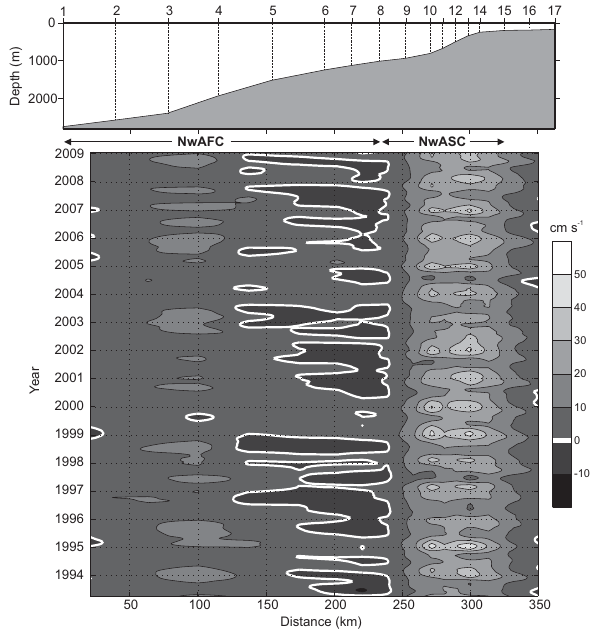
Fig. 2. Upper figure: bottom topography with the fix hydrographic stations in the Svinøy section. Lower figure: Hovm¨oller plot of sur- face currents through the section based on the absolute sea surface dynamic height data. The data are three months moving averages. Shaded contour interval is 10cms − 1 , and white contour lines are zero velocities. The Norwegian coast is to the right, and the distance in x-axis is relative to the westernmost station (1) that yields for all figures. The hydrographic stations associated with the NwASC and NwAFC volume fluxes are